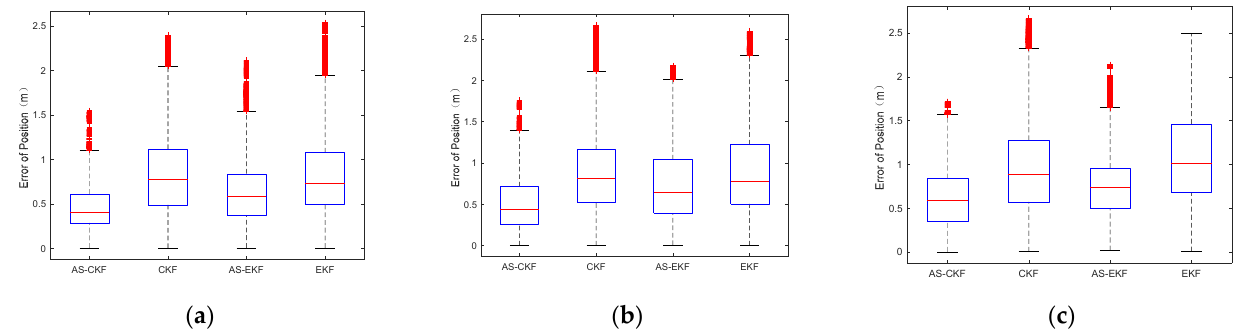
Figure 13. Position error boxplots of different algorithms under different delay conditions: ( a ) represents the time delay τ = 20 ms, ( b ) represents the time delay τ = 40 ms, and ( c ) represents the time delay τ = 100 ms.